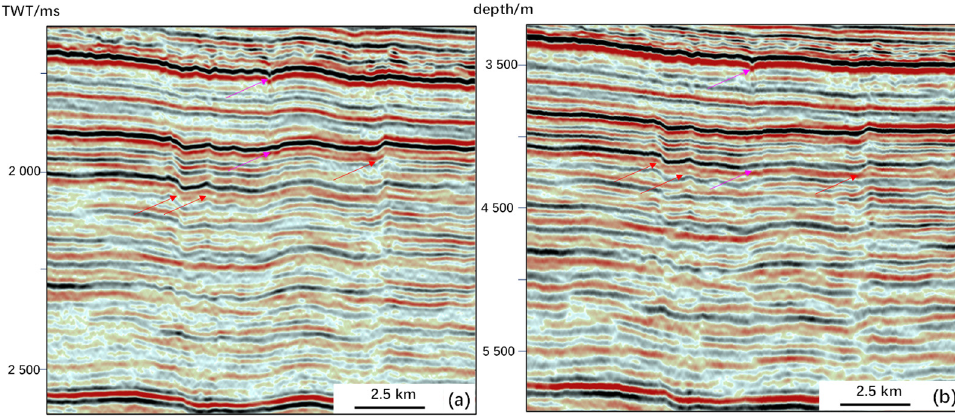
Figure 2. Seismic sections by ( a ) prestack time migration and ( b ) prestack depth migration processes in Anyue Gasfield (the red arrows indicating strike-slip fault; the pink arrows showing false image could be inferred to be strike-slip fault).